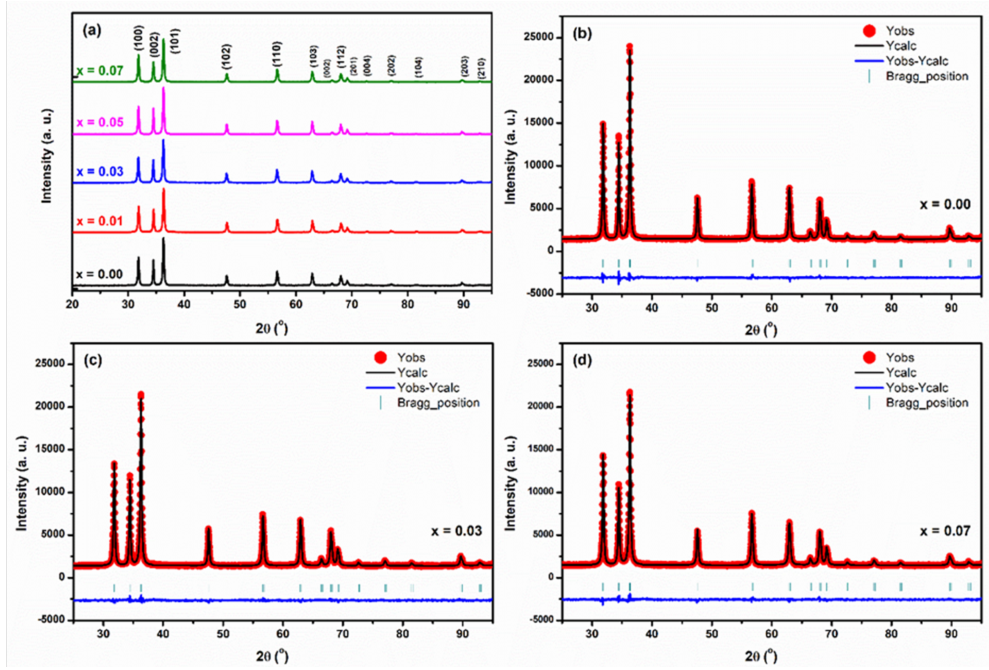
Figure 1. ( a ) XRD patterns of Zn 1 − x Li x O nanocrystalline samples calcined at 350 ◦ C. Rietveld